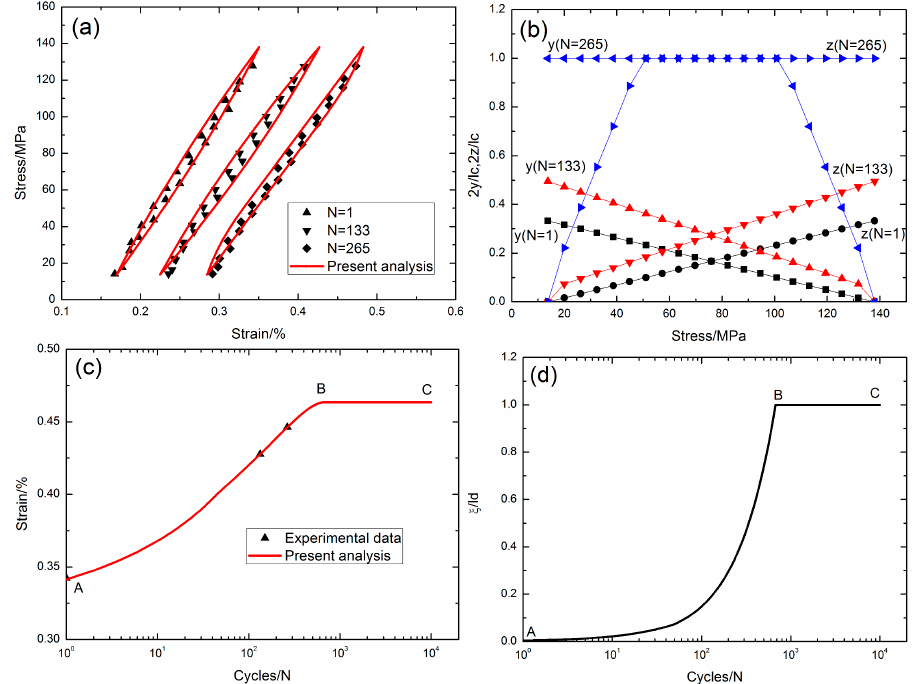
Figure 11. ( a ) The fatigue hysteresis loops corresponding to different applied cycles; ( b ) the interface slip lengths versus applied stress corresponding to different cycle numbers; ( c ) the peak strain versus cycle number curves; and ( d ) the interface oxidation length ξ / l d versus cycle number curve of cross-ply SiC/MAS composite under σ max = 138 MPa at 566 °C with stress rupture time of t = 10 s.